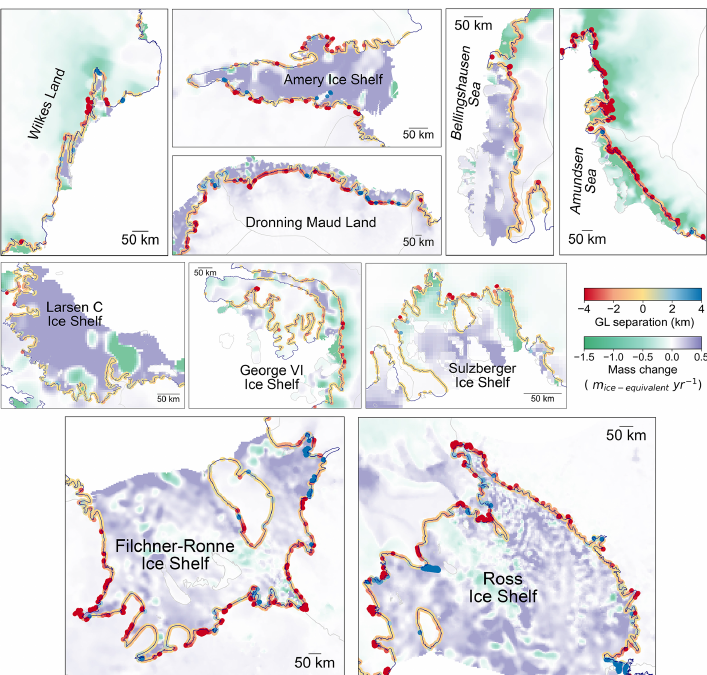
Figure A4. Spatial distributions of the separations between the ASAID-derived break in slope and ICESat-2-derived break in slope (Point I b ) (the negative value is retreating, while the positive value is advancing) in individual regions in Table 3; the spatial extents of each region are shown as dashed grey boxes in Fig. 10. In all subplots, data are superimposed over the recent mass change map (Smith et al., 2020b); the black line is the ASAID-derived break in slope (Bindschadler et al., 2011), and the light-grey line is the IMBIE basin boundary (Shepherd et al., 2018; Rignot et al.,